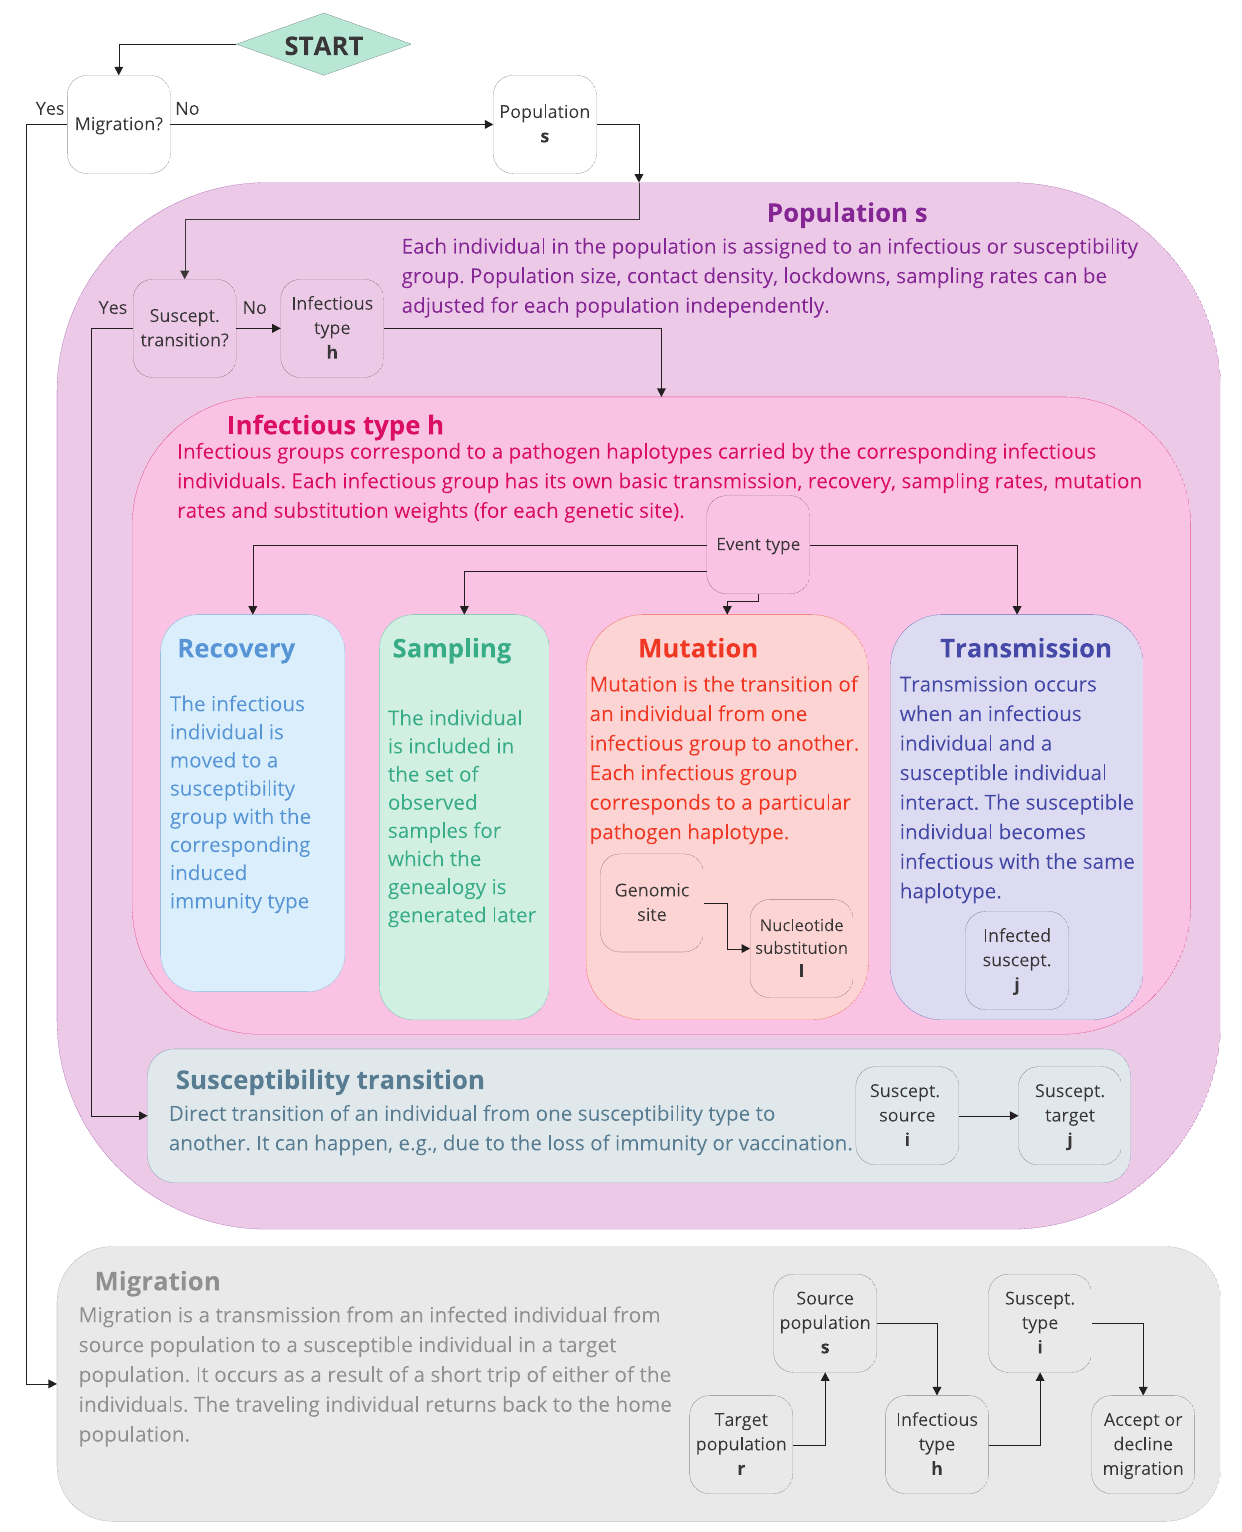
Fig 1. The scheme of the nested family Gillespie algorithm used to generate an event in the forward run. The corresponding reactions are listed in Table 1. Black squares correspond to the consecutive steps, where the subfamilies are chosen with the weights given by their propensities. The propensities for each step are cached and updated only if they change due to an event. For migration propensities, the rejection approach is used instead (S1 File—section 3).